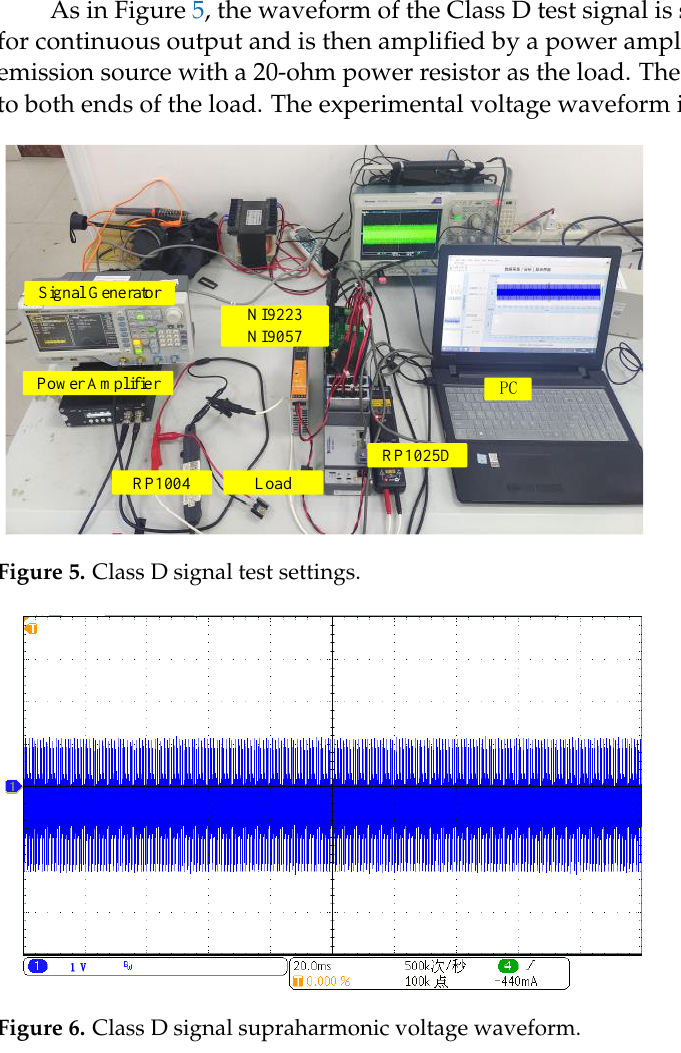
Figure 7. Class D signal test experimental results. 4.2. LED Supraharmonic Emission Test This test measures an LED lamp with a switching frequency of approximately 100 kHz and a power of 30 watts, using an AC laboratory power supply to power it . As shown in Figure 8, a voltage probe and a current probe are connected at the connection point between the power supply and the LED lamp. The voltage and current waveforms of the LED lamp obtained from the test are shown in Figure 9. PC RP1025D RP1004 30W LED AC Power NI9223 NI9057 Figure 8. LED test settings.